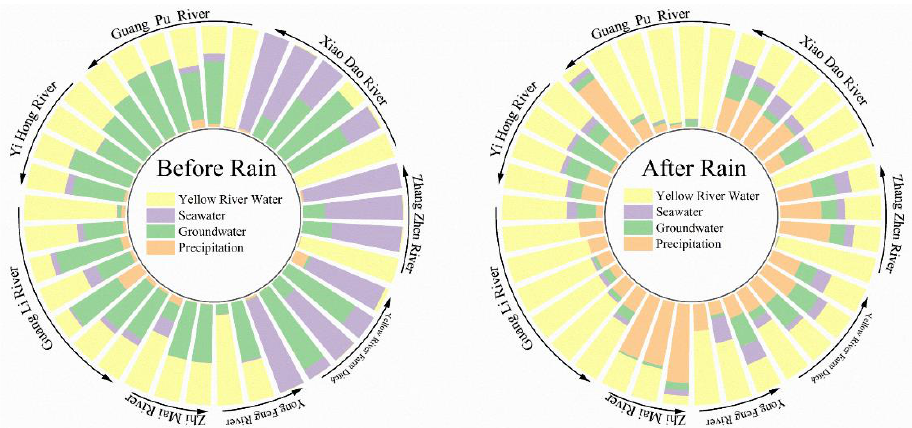
Figure 5. Changes in recharge from upstream to downstream regions in the study area before and after the rains.